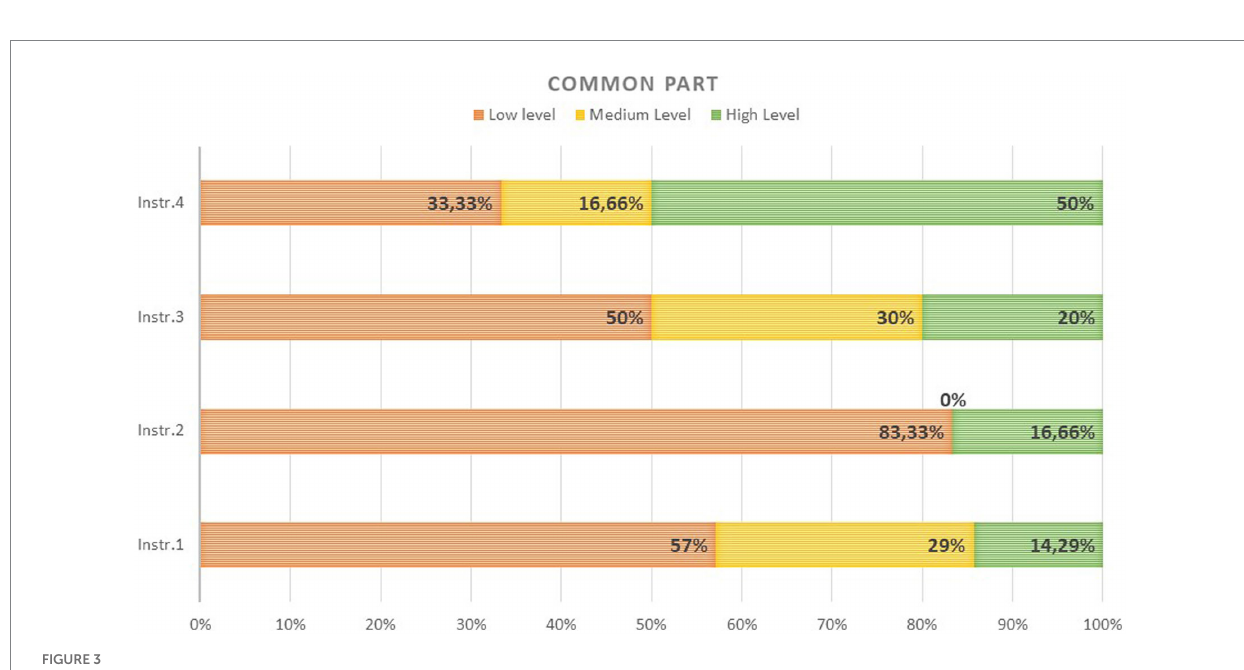
FIGURE 3 Exams’ common part. Cognitive